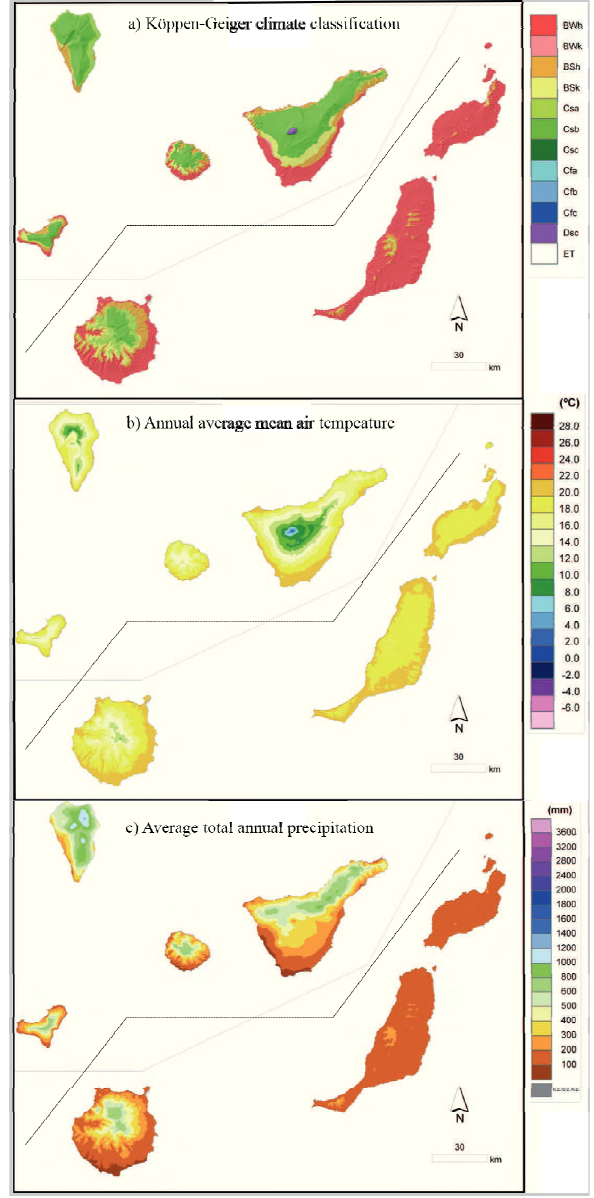
Figure 3. Climate of the Canary Islands from (AEMET, 2012); a) Köppen-Geiger Classification; b) Average annual temperature in °C; c) average total annual precipitation in mm. Islands were re-arranged for better fit on